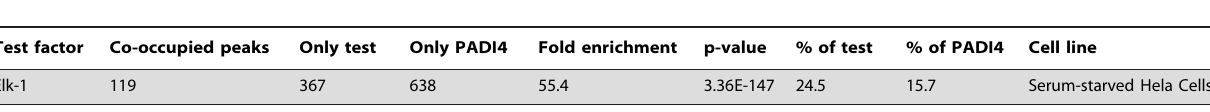
Table 2. Comparison of PADI4 ChIP-chip with Elk-1 ChIP-chip dataset [33].